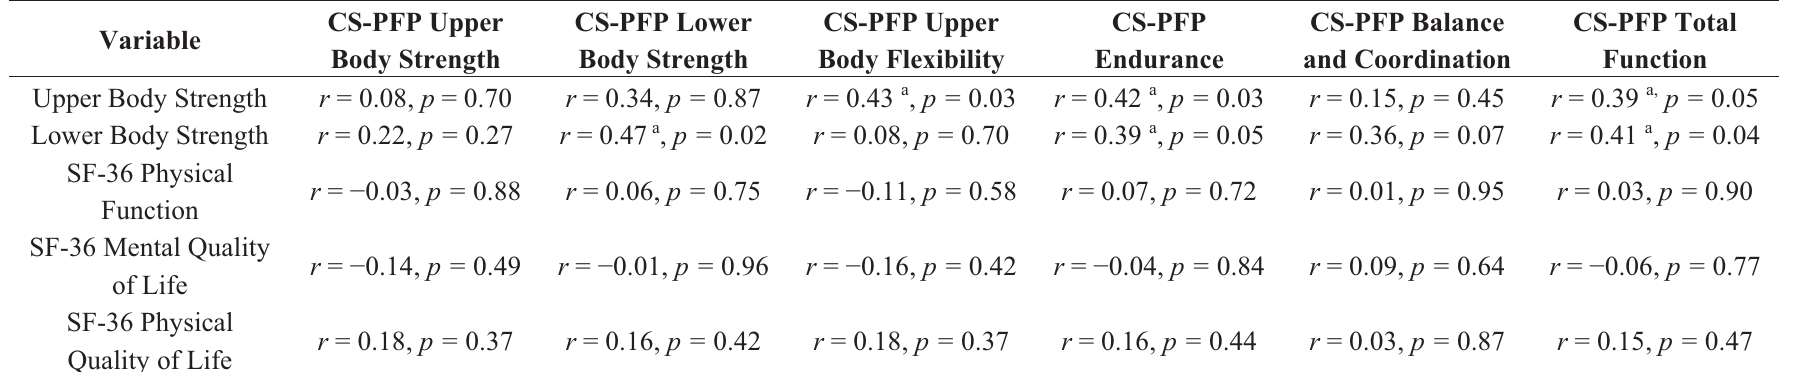
Table 6. Pearson Product Moment Correlations between Percent Change in CS-PFP* and Percent Changes in Strength and SF-36** ( N =